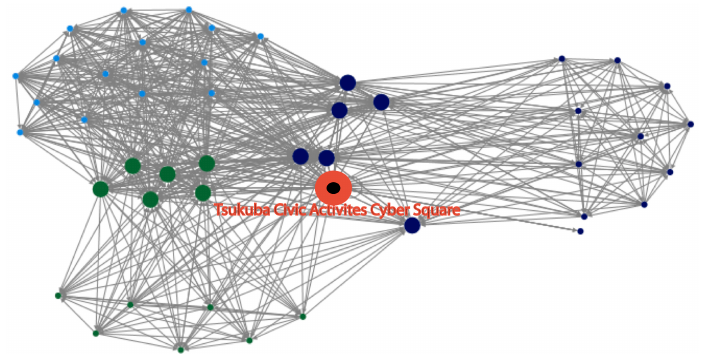
Figure 3. Node XL analysis result map of Tornado in Hojo, Ibaraki (12 June 2012).